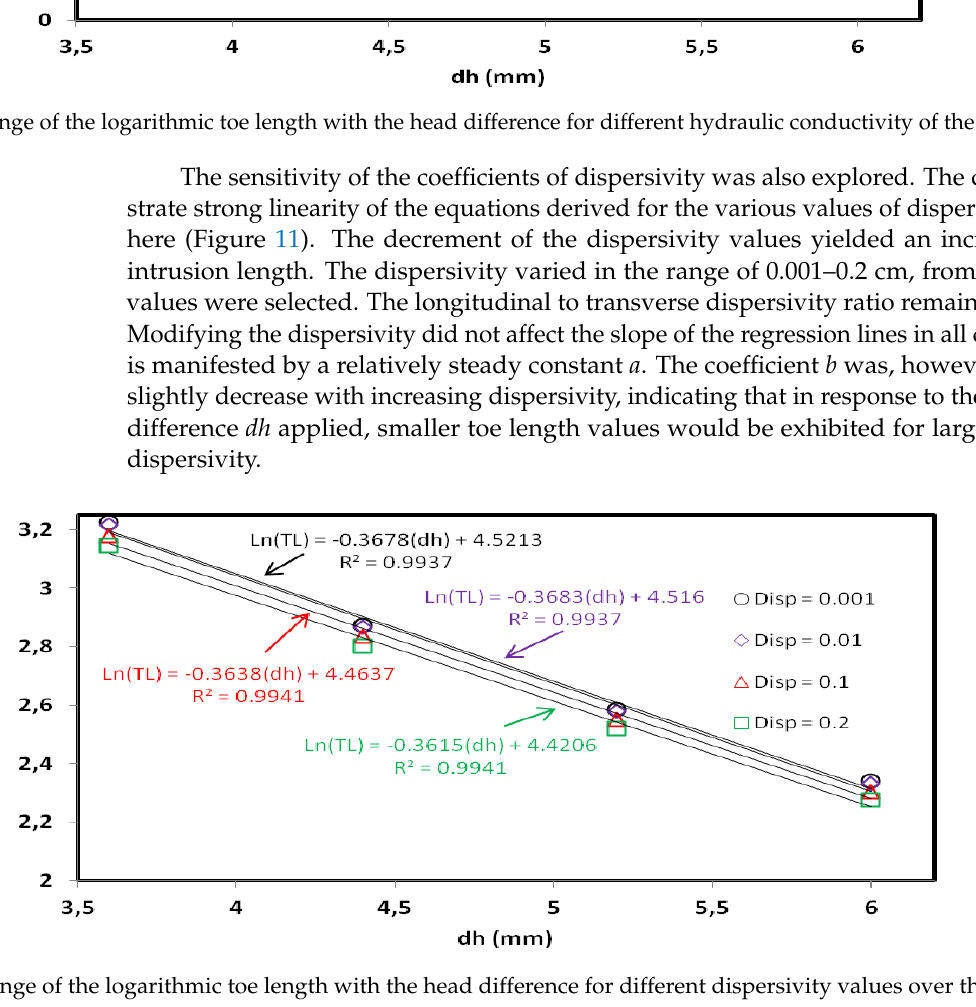
Figure 10. Change of the logarithmic toe length with the head difference for different hydraulic conductivity of the aquifer.